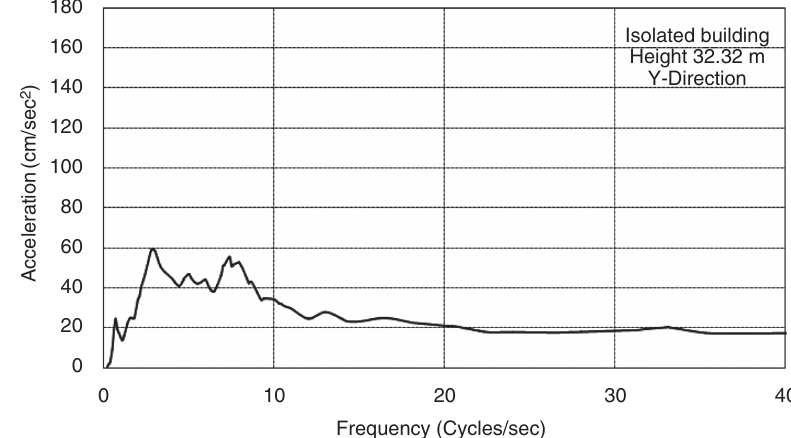
Fig. 13. Spectral Acceleration in Y-direction (isolated building)